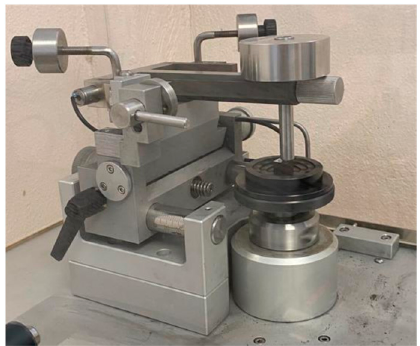
Figure 2. Pin-on-disc sliding wear